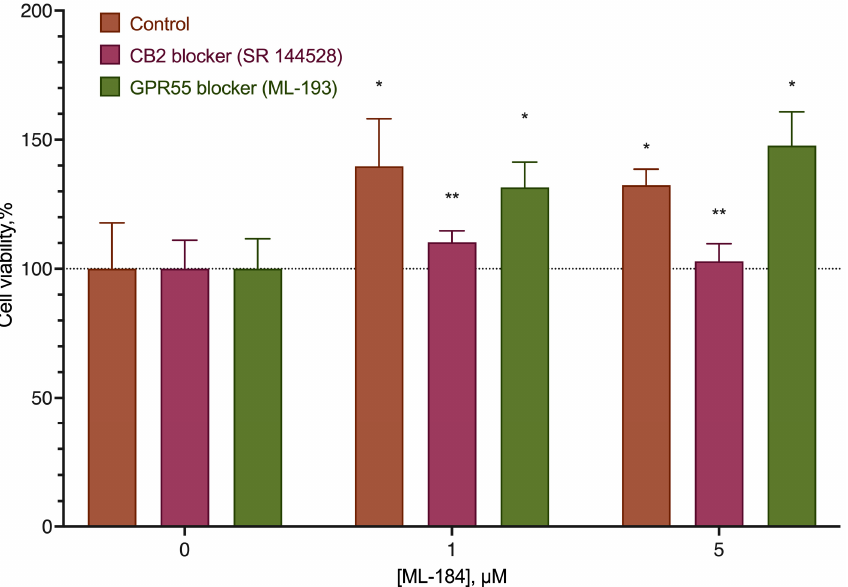
Figure 6. The effect of ML-184 on the original cell line against the background of GPR55 (ML-193) and CB2 (SR 144528) blockers. *, a statistically significant difference from control without ML-184; **, a statistically significant difference from the substance without blocker, and ANOVA with Holm–Sidak post-test.